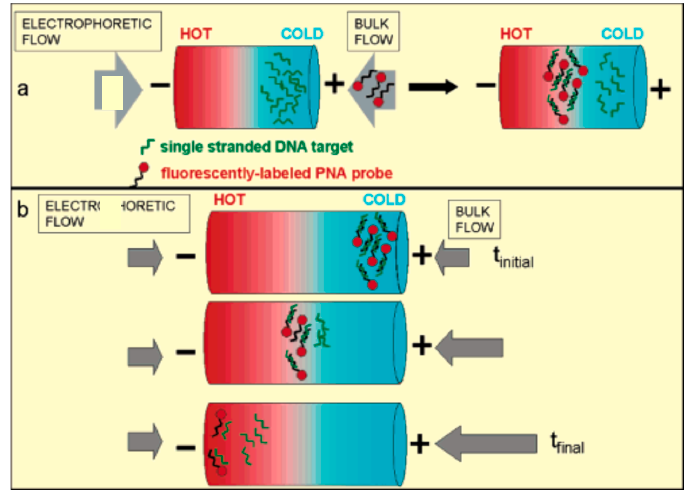
Figure 5. Principle of the two-step temperature gradient focusing (TGF) assays. ( a ) The first-step assay is stationary, and the ssDNA targets are first focused with TGF and then the PNA probe is introduced to the focused DNA with the bulk flow. ( b ) The second-step assay is dynamic. The DNA/PNA hybrid is first focused with TGF to the cold side and then the bulk flow is adjusted to move the analyte against the temperature gradient so that its melting temperature can be determined by observation of the change of fluorescent intensity with temperature. Reprint from Ref. [59].